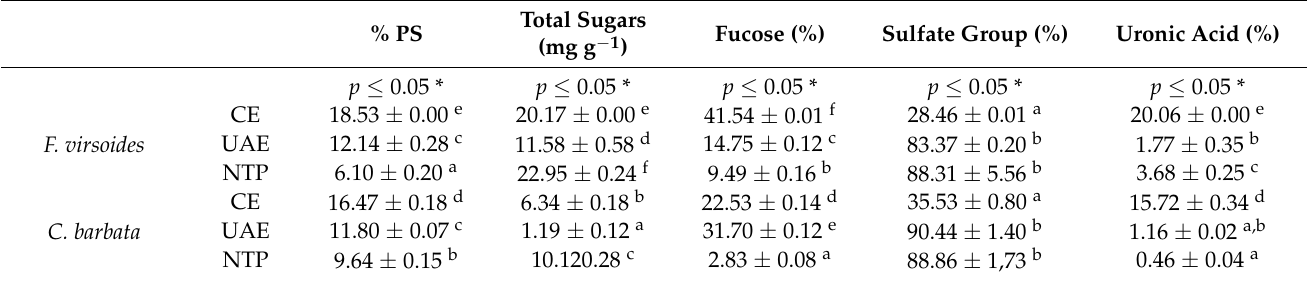
Table 4. Polysaccharide yield (%PS) and chemical composition of Fucus virsoides and Cystoseira barbata polysaccharides obtained with CE, UAE and